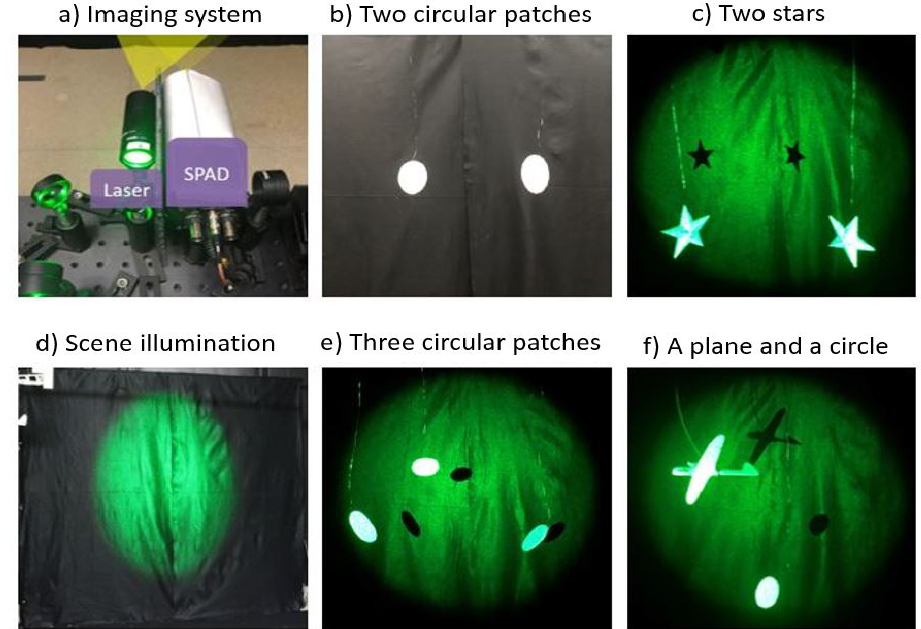
Figure 5. Imaging system and examples of the scene ( a , d ) The imaging system with co-located ultrafast pulsed laser and SPAD. We placed a diffuser in front of the laser to scatter the laser light into the scene. Note there is no lens before SPAD. On the right, the scene with illumination is shown. ( b , c , e , f ) Examples of the test scenes. All of the targets have a dimension approximately 4 × 4 cm, except the plane, which has dimensions 8 × 8